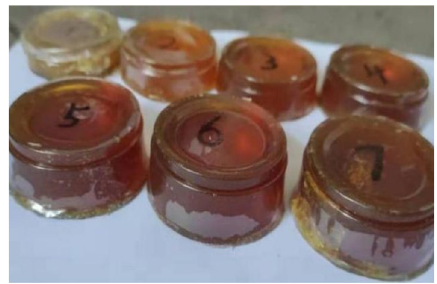
Figure 9. Compressed specimens.